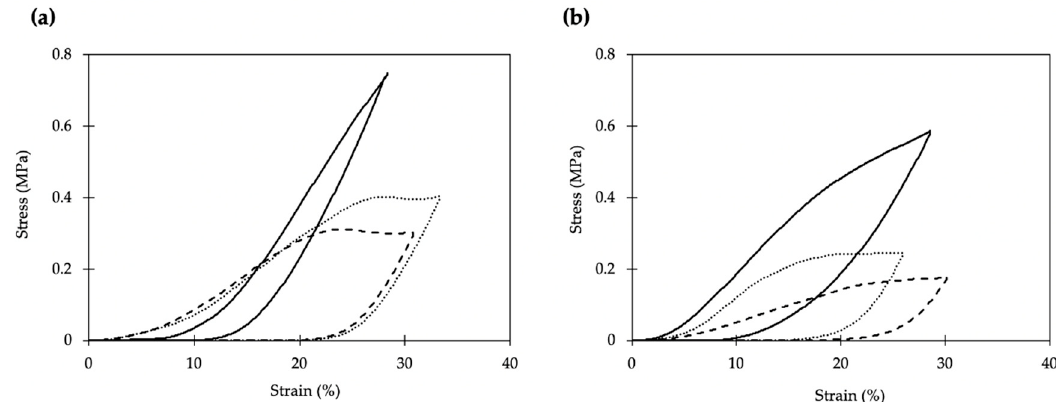
Figure 4. Stress-strain response under uniaxial compression of the manufactured scaffolds: ( a ) PCL50BA formulations, and ( b ) PCL75BA formulations with different drug (K) contents (0, 5, and 10 wt.%). Legend: black line (0 K); dotted line (5 K) and dashed line (10 K).